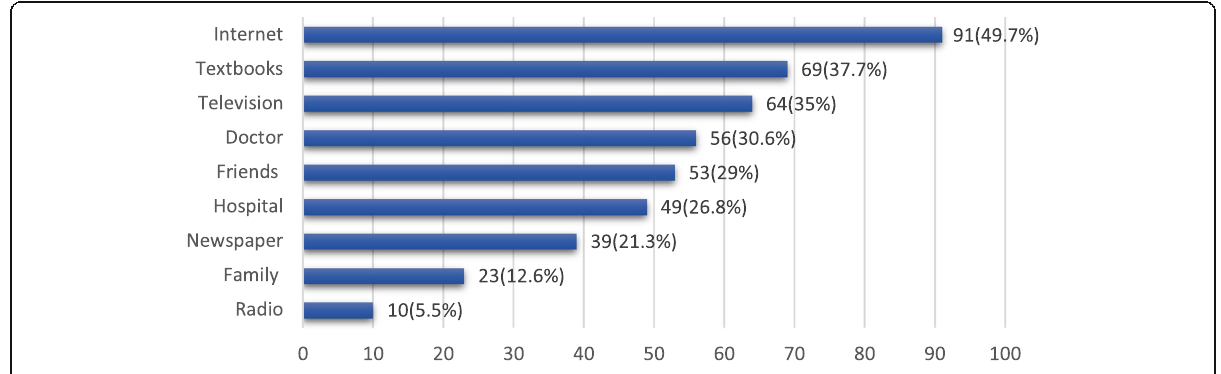
Fig. 1 The source of information about the emergency contraception (multiple response